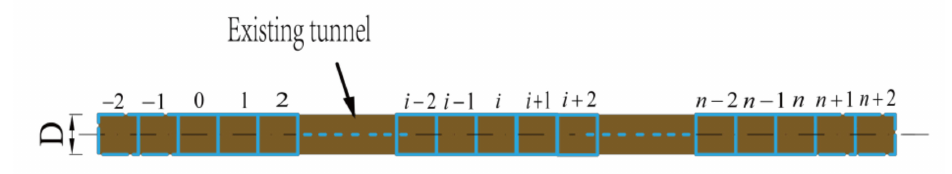
Figure 6. Finite difference form of the existing